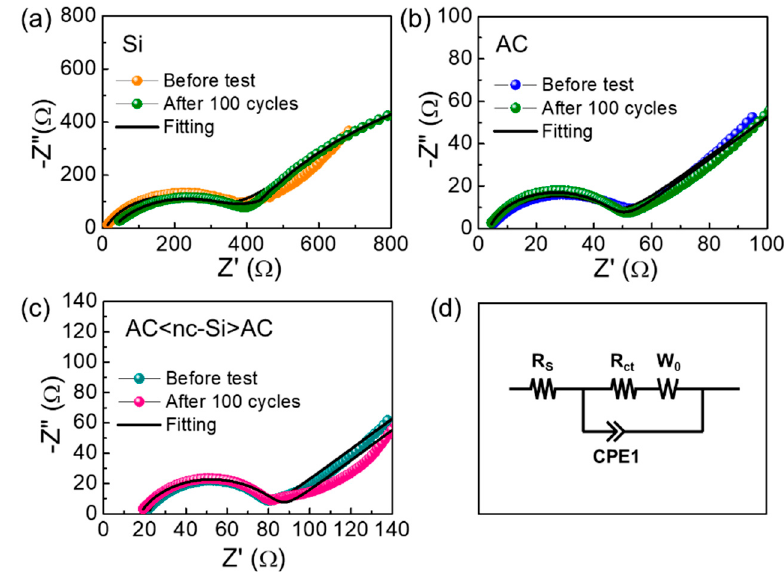
Figure 8. Nyquist plots measured at the discharged state before and after the stability test for the LIB devices with the ( a ) nc-Si, ( b ) AC, and ( c ) AC<nc-Si>AC nanocomposites as anode materials. ( d ) Equivalent circuit used for the fitting analysis of the LIB device.